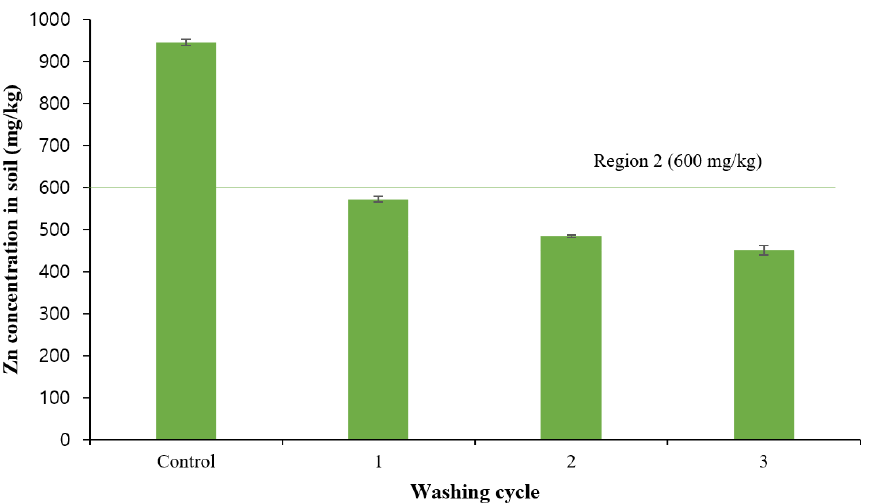
Figure 11. Zn concentrations remaining in the soil after 1, 2 and 3 high-pressure washing cycles.